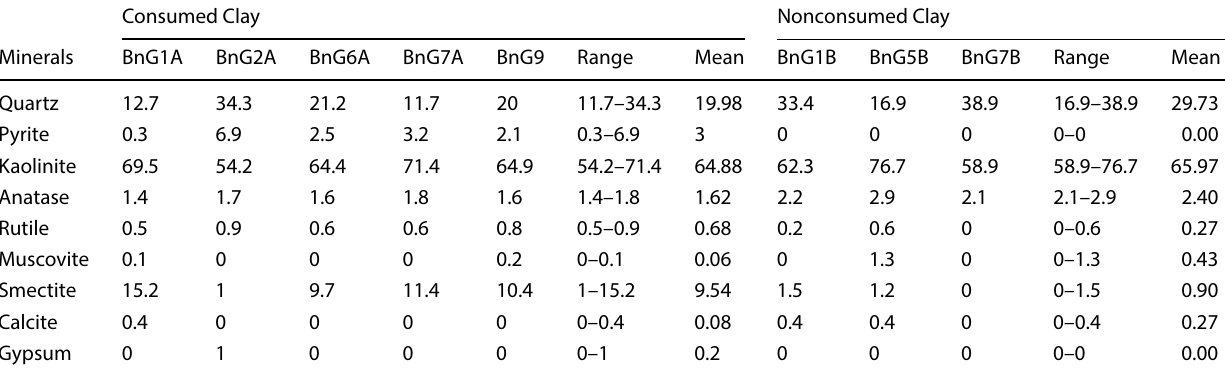
Table 5 Mineralogical Composition of Geophagic Clays in the study area (%) Consumed